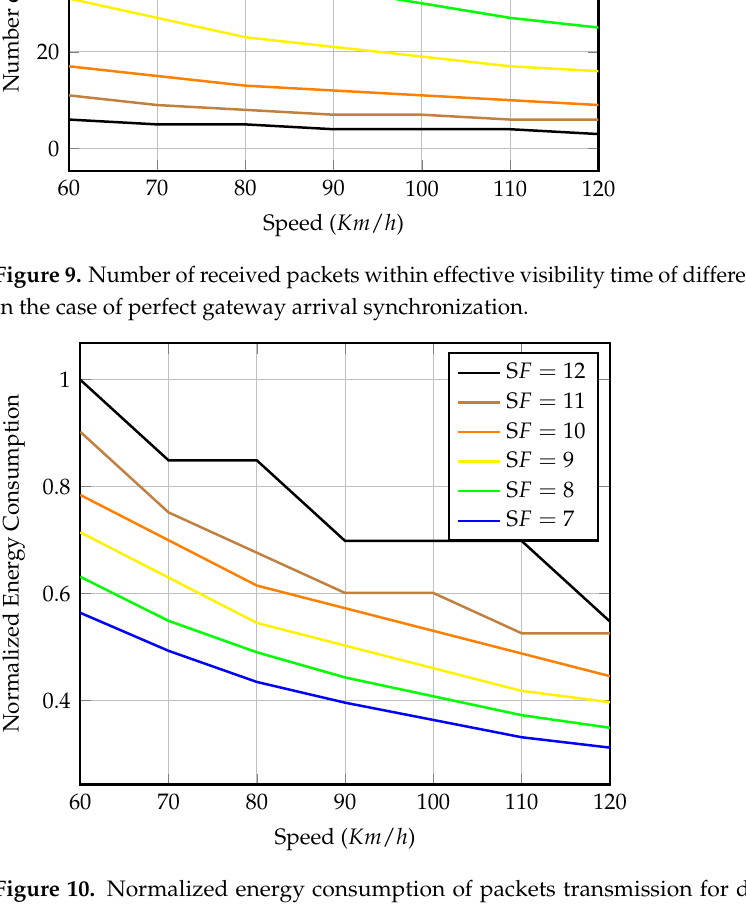
Figure 10. Normalized energy consumption of packets transmission for different speeds and SF values in the case of perfect gateway arrival